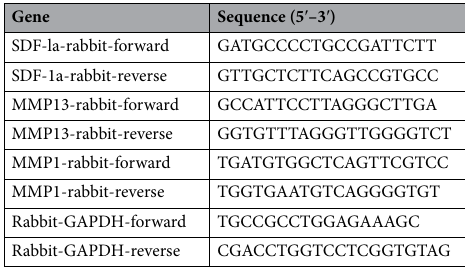
Table 1. PCR Primer sequences.